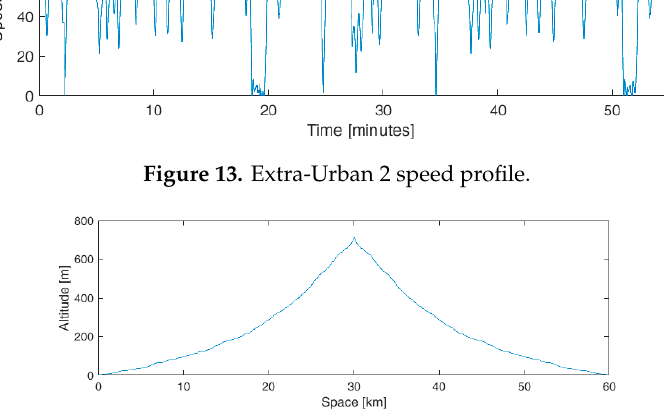
Energies 2019 , 12 , x FOR PEER REVIEW Figure 14. Mountain mission 2 altitude profile. Figure 14. Mountain mission 2 altitude profile. Figure 14. Mountain mission 2 altitude profile.